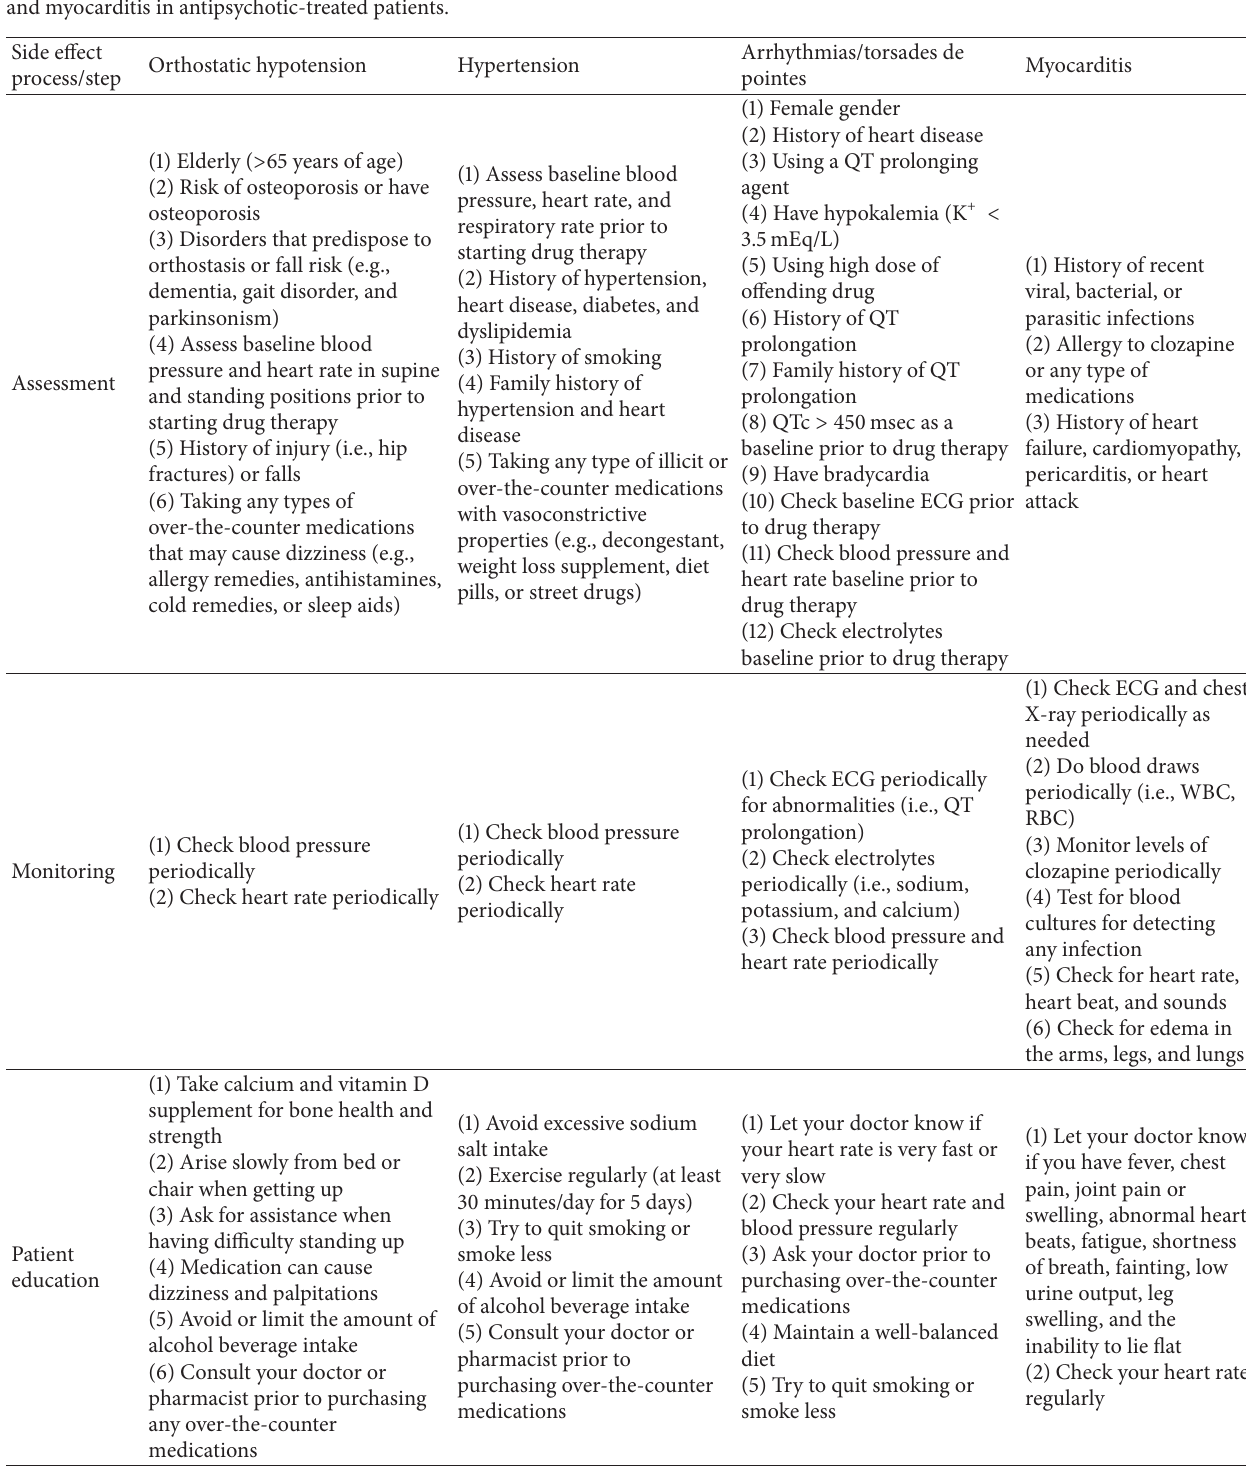
Table 2: Assessment, monitoring, and patient education regarding orthostatic hypotension, hypertension, arrhythmias/torsades de pointes, and myocarditis in antipsychotic-treated